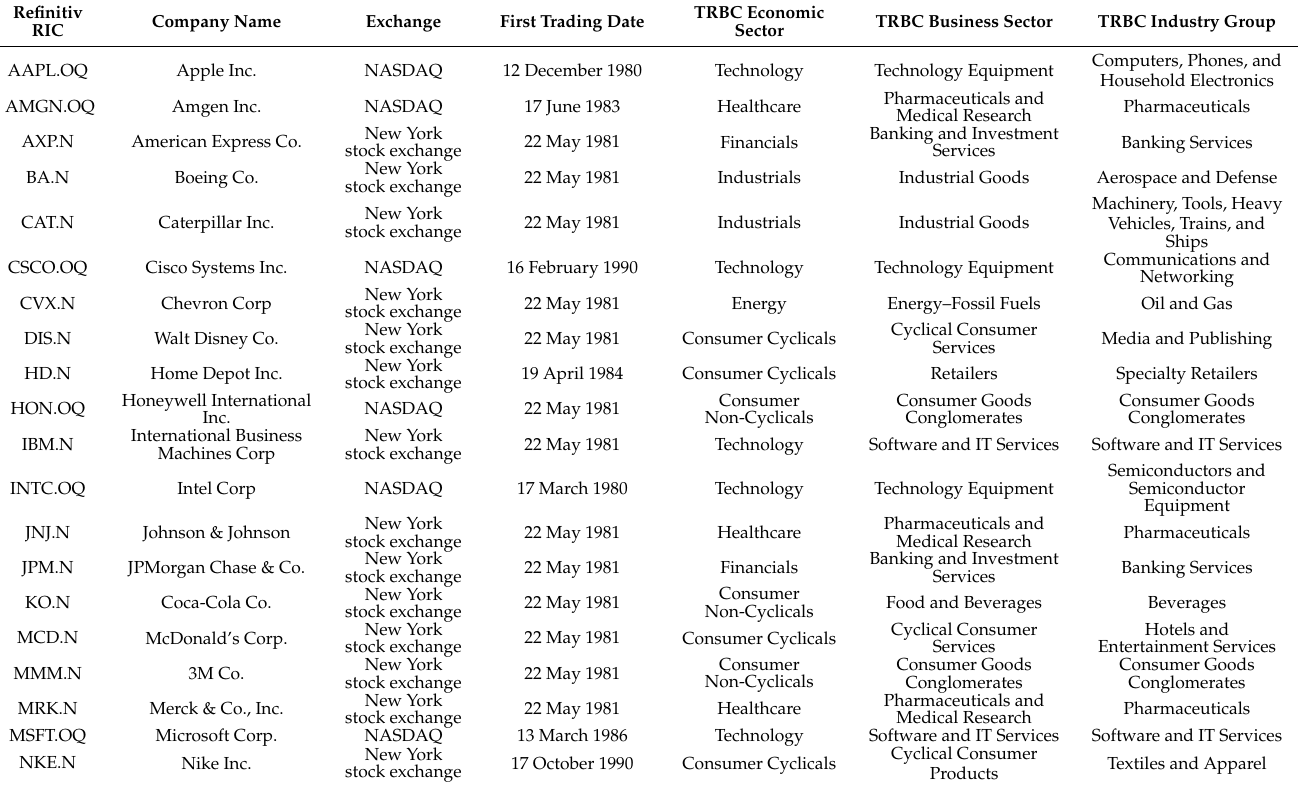
Table A1. Stocks of the investment universe in our